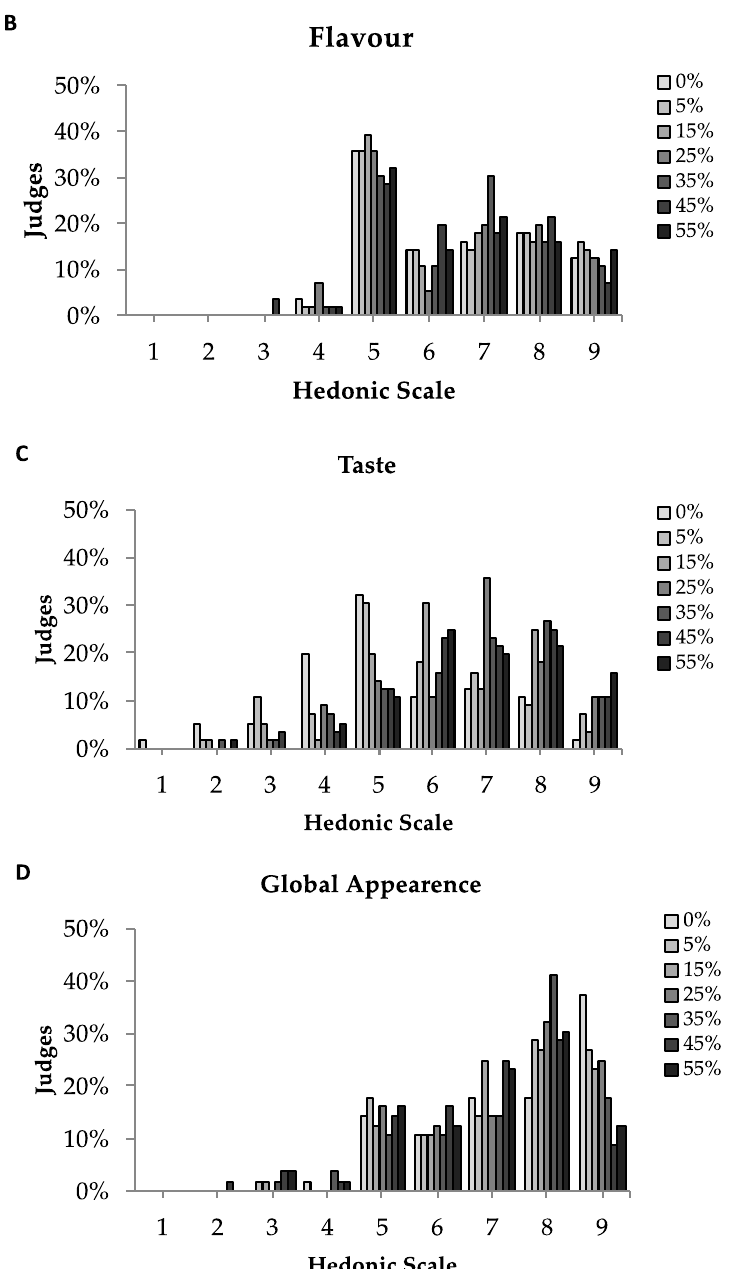
Figure 5. Sensory evaluation of films, using a hedonic scale ( A ) colour ( B ) flavour, ( C ) taste and ( D ) global acceptance. Mean of 56 consumers for each sample. Scores for global appearance: colour, flavour, taste and overall acceptance: 1 = disliked extremely; 2 = disliked very much; 3 = disliked moderately; 4 = disliked slightly; 5 = liked / disliked; 6 = liked slightly; 7 = liked moderately; 8 = liked very much; 9 = liked extremely.